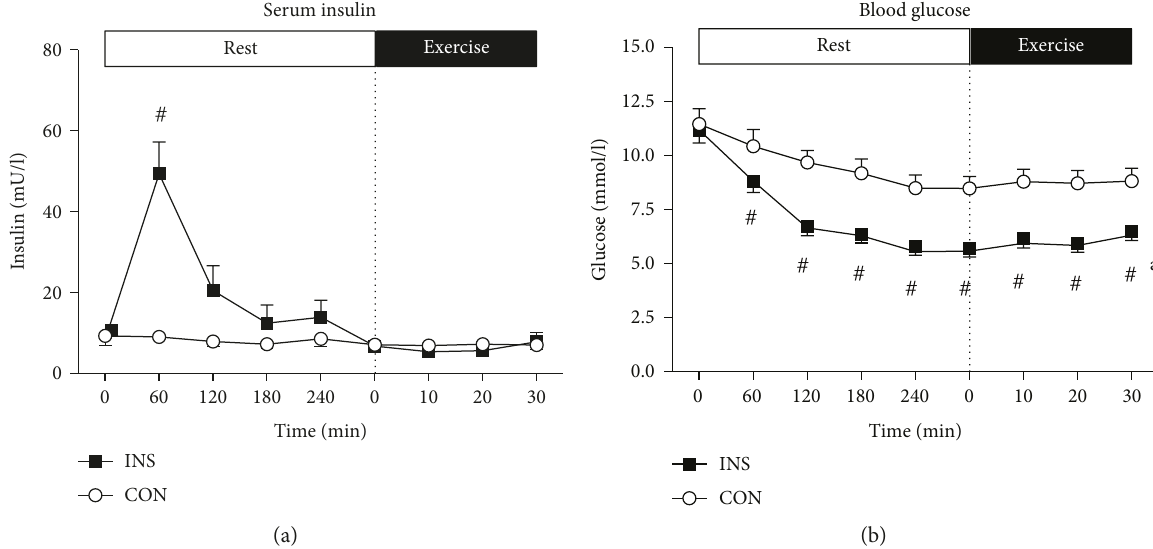
Figure 1: Serum insulin (a) and blood glucose (b) concentrations during the INS and CON trials. Data represent n = 6 , mean ± SEM. (a) During the resting phase, the infusion signi fi cantly increased serum insulin in INS compared to CON (main e ff ect of infusion, P < 0 01 ); there were also signi fi cant interaction ( P < 0 0001 ) and time ( P < 0.0001) e ff ects. During exercise, there was no e ff ect of infusion, time, or an interaction. (b) At rest, the infusion signi fi cantly lowered blood glucose in INS compared to CON (main e ff ect of infusion, P < 0 01 ); there were also signi fi cant interaction ( P < 0 0001 ) and time ( P < 0 0001 ) e ff ects. During exercise, blood glucose increased signi fi cantly in INS ( P < 0 01 ) but not in CON. # P < 0 0001 from CON; a P < 0 01 from immediately before exercise (0 min).